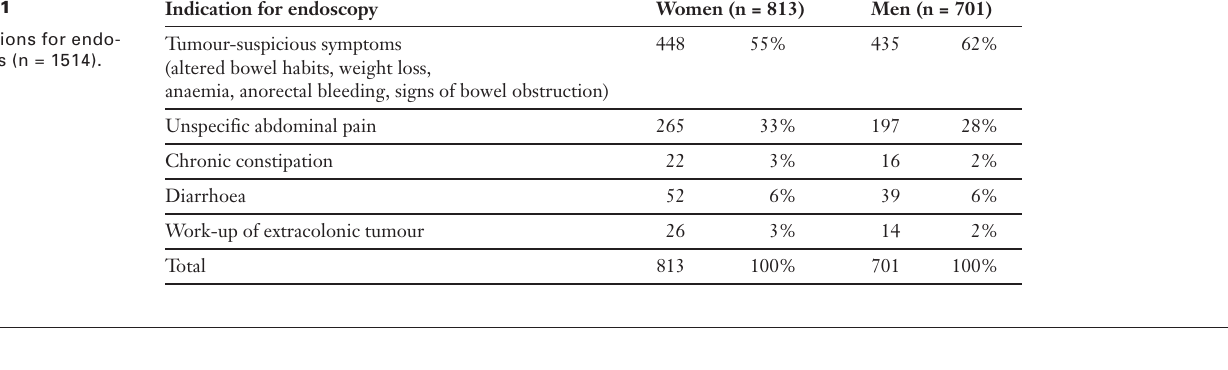
Table 2 Findings in work-up of tumour suspicious symptoms compared to unspecific symp- toms (data given in raw numbers and %, up to two indications in every patient recorded).